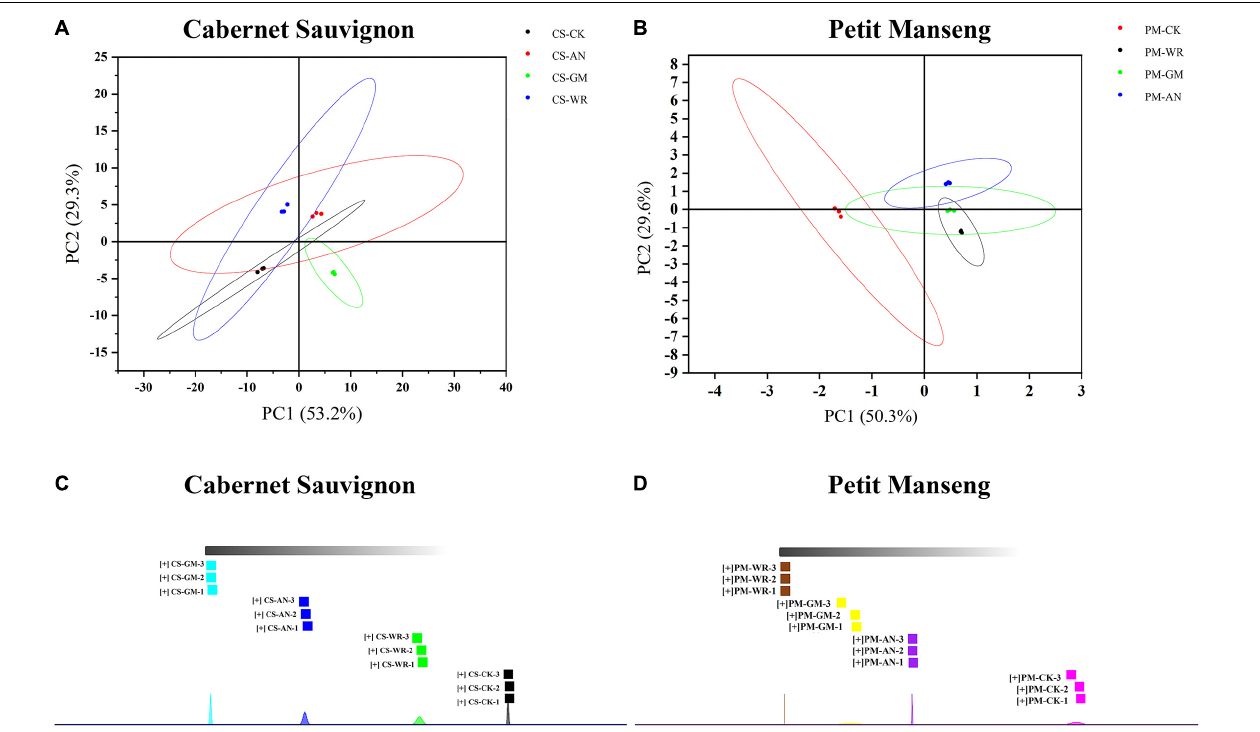
FIGURE 4 | (A, B) Principal component analysis (PCA) score plot and (C, D) nearest neighbor fingerprint (NNA) of Cabernet Sauvignon and Petit Manseng wine grapes. The bottom area of NNA shows the normal distribution of each sample.